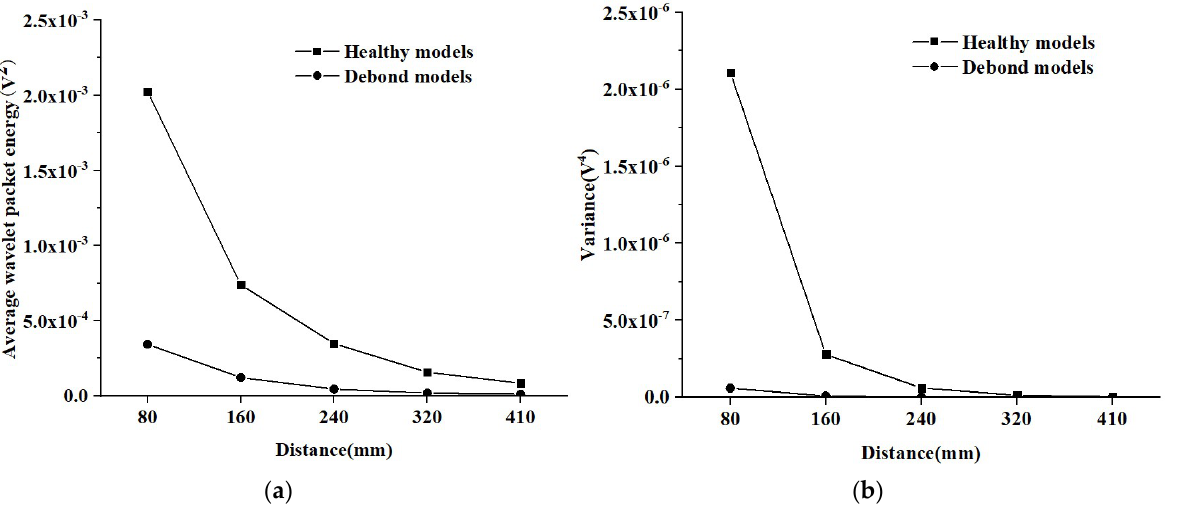
Figure 17. Comparison of average wavelet packet energy and variance in responses of PZT sensors shown in Figure 16 for three CMFEMs and three CHFEMs with and without debond defects. ( a ) Average wavelet packet energy; ( b ) Variance.